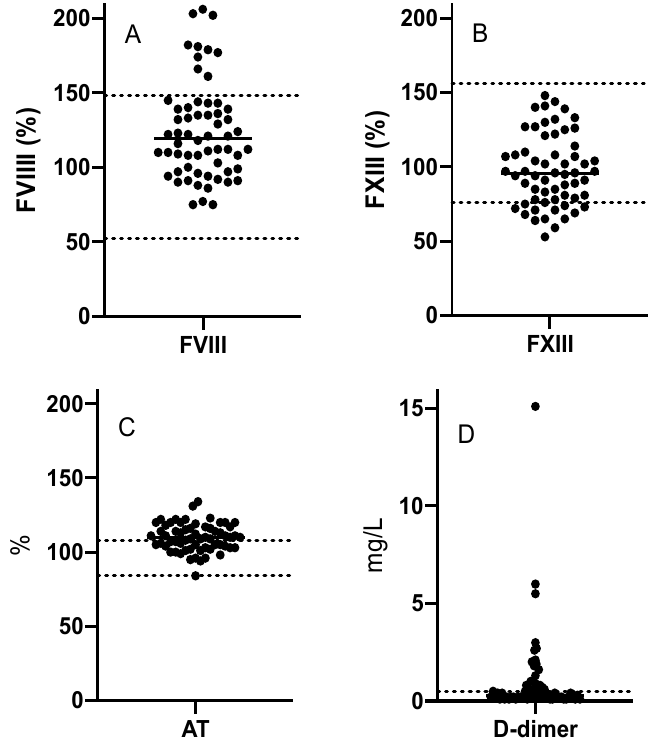
Figure 3. Coagulation factors VIII ( A ) and XIII ( B ), antithrombin ( C ), and D-dimer ( D ) in patients with venous malformatons. Dotted lines depict reference ranges for each variable.